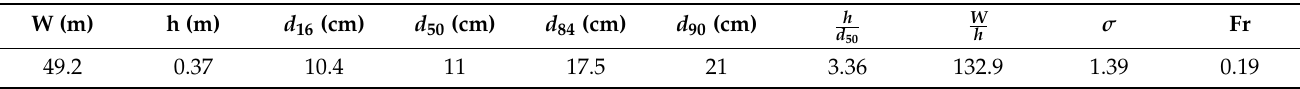
Figure 1. The location of the study area in the Pelasjan River. Table 1. Geometric and hydraulic characteristics of the selected area in the Pelasjan River.